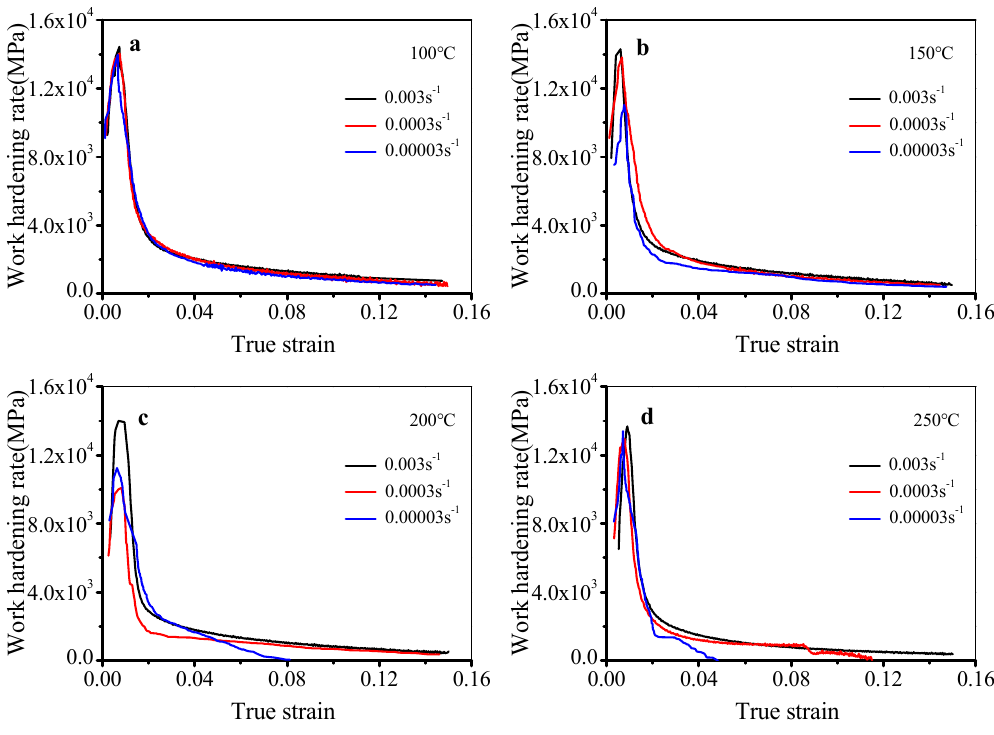
◦ C, ( b ) 150 ◦ C, ( c ) 200 ◦ C, and ( d ) 250 ◦